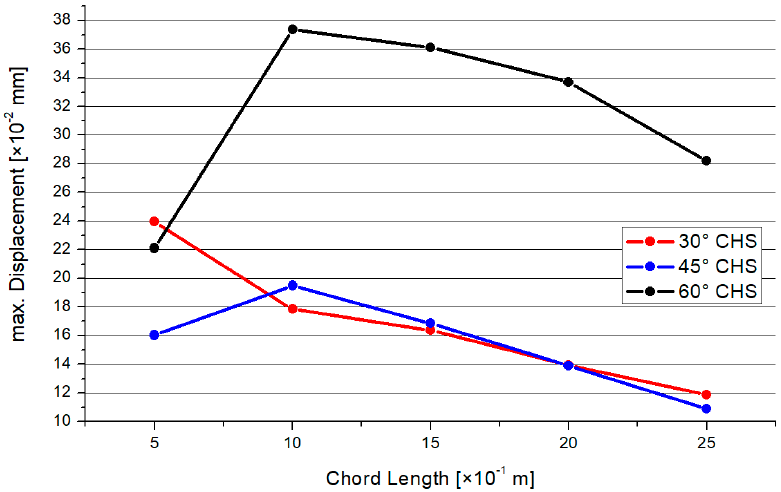
Figure 19. Results—Maximum Deflection.